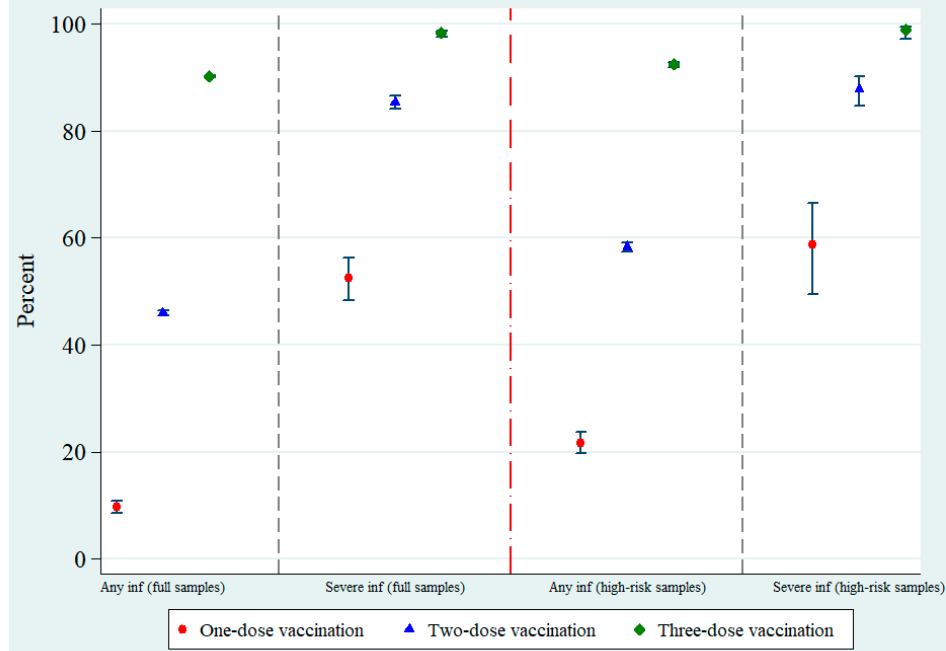
Figure 2. Vaccine effectiveness against any infection and severe infection for each vaccination status (any combination of vaccine brands). Note: Vertical bars denote 95% confidence interval; p < 0.001 for all schedules.